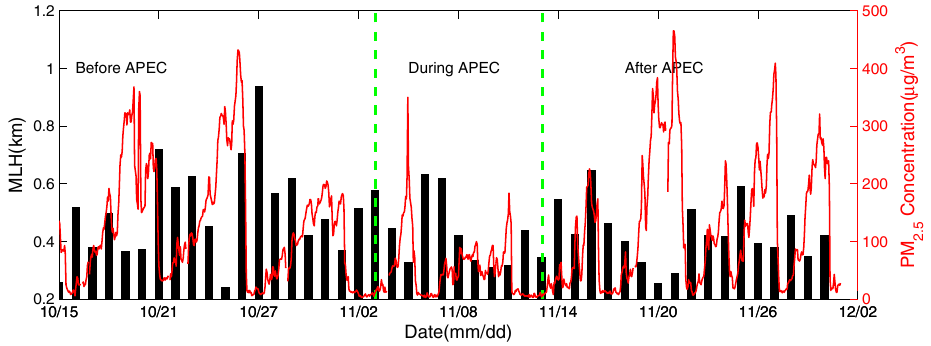
Figure 2. PM 2 . 5 concentrations and mixing-layer heights vs. time from 15 October to 30 November